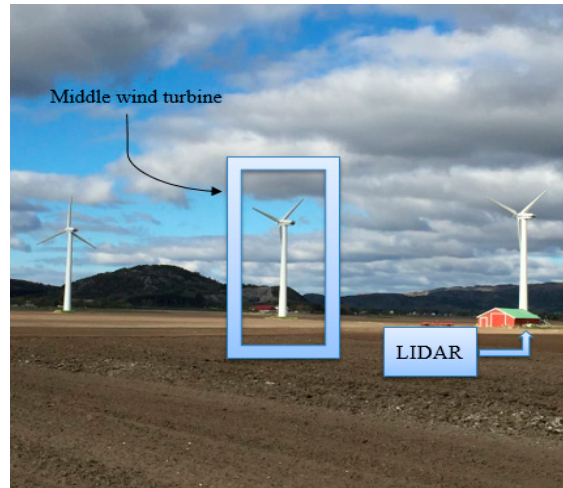
Figure 3. Wind farm under consideration. Table 1. Vestas V-27 specifications.